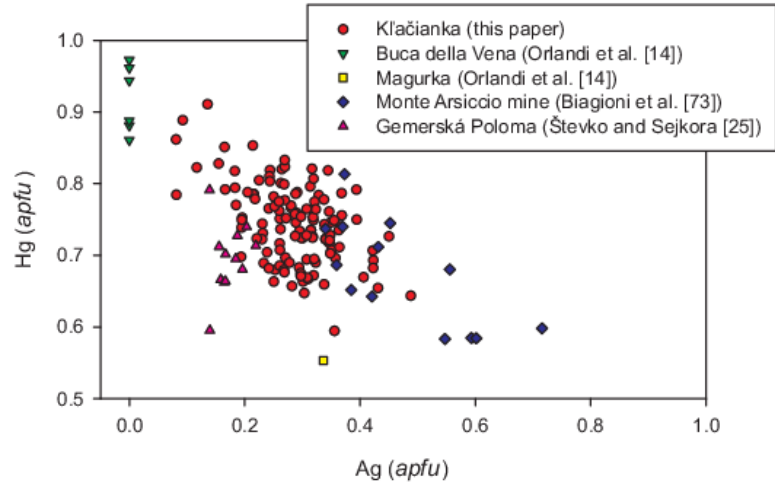
Figure 12. Chemical composition of rouxelite in the graph Ag vs. Hg (apfu ).